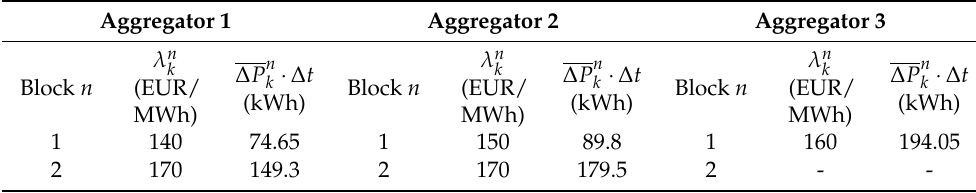
Table 3. Upward balancing energy bids submitted by aggregators.